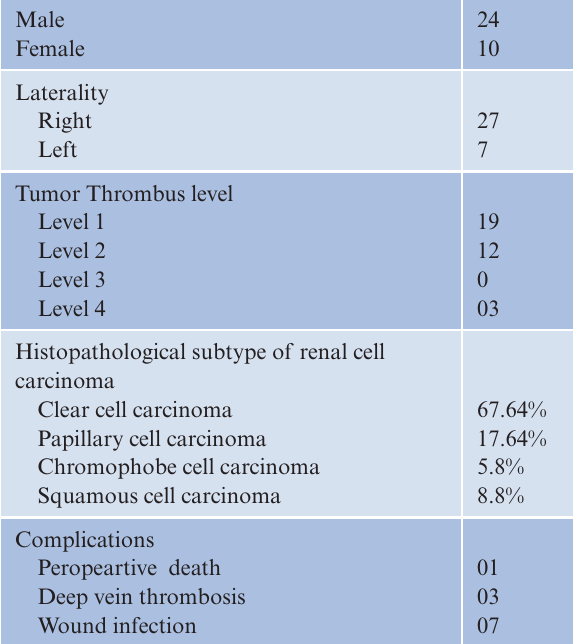
Table 1: Clinical profile of patients (N =